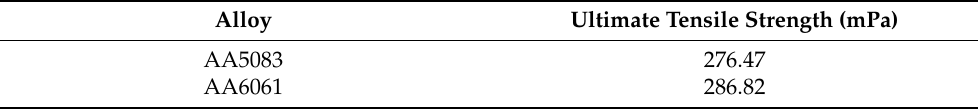
Table 2. Mechanical properties of the aluminum